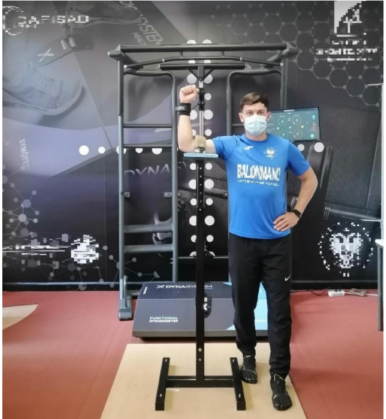
Figure 1. Shoulder internal rotation strength